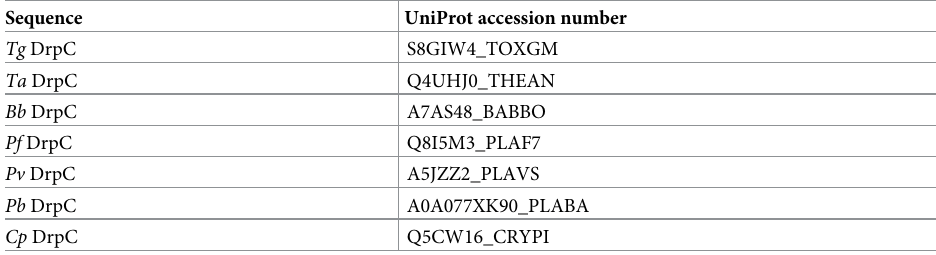
Table 3. accession numbers of sequences used for